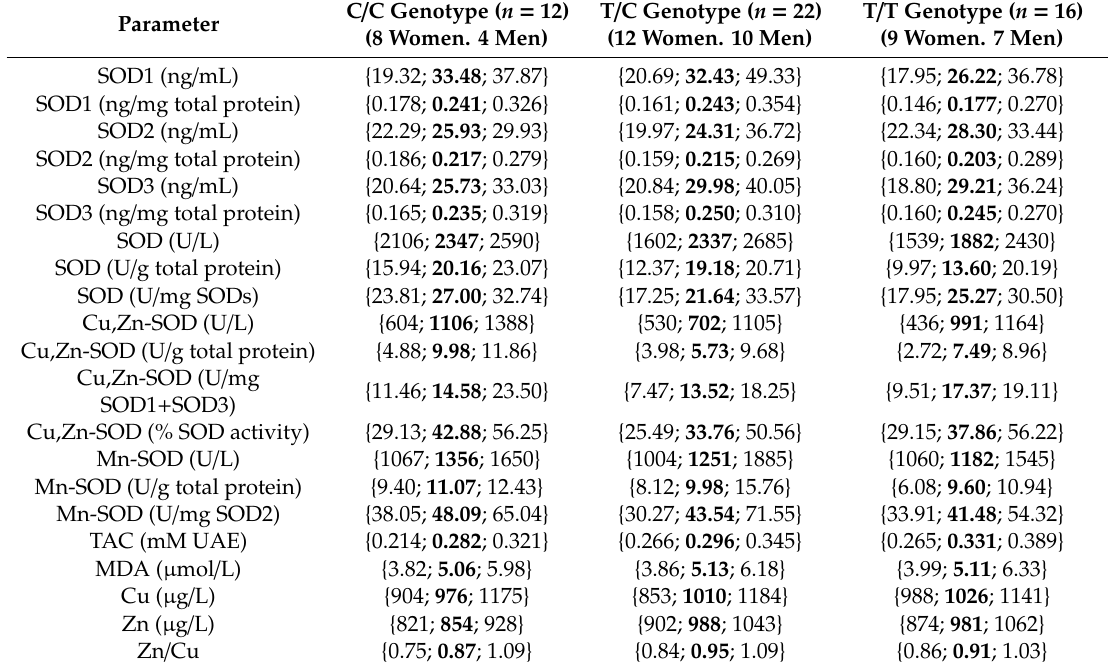
Table A3. Values of selected pro- and antioxidative parameters, and concentration of selected metals, in context of genotypic variability of rs927450 ( SOD2 ), in non-obese individuals.